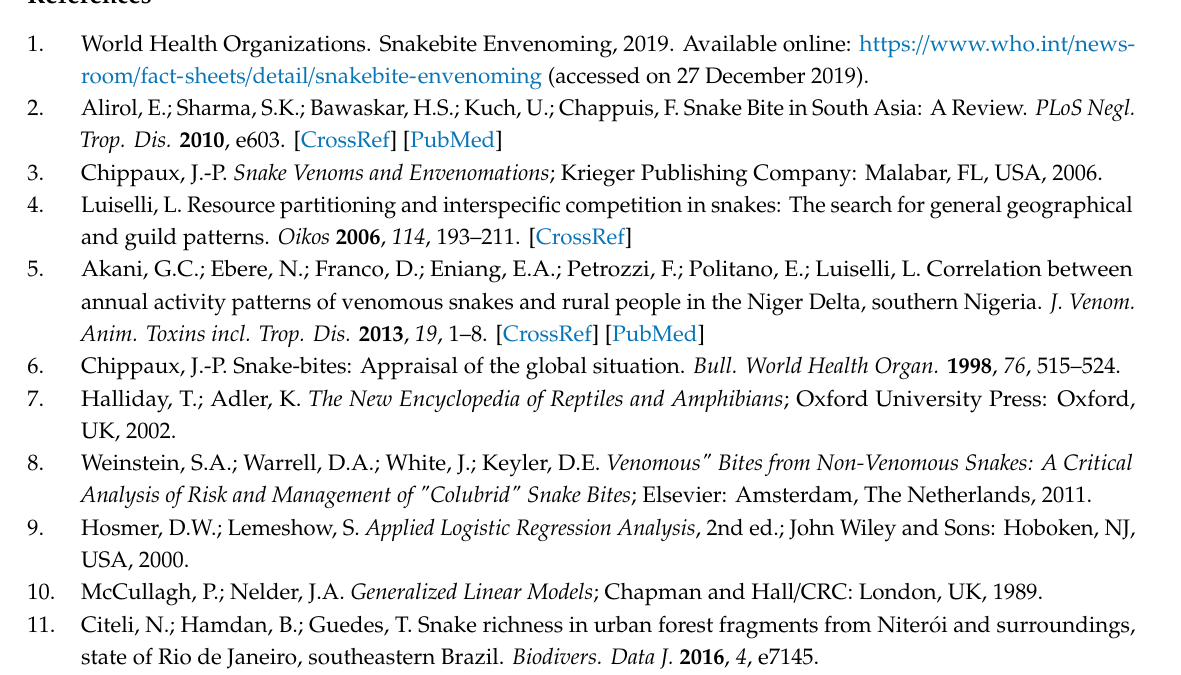
Table S1: Raw data on the snake communities analyzed during the present study. Numbers in brackets refer to citations given in the main